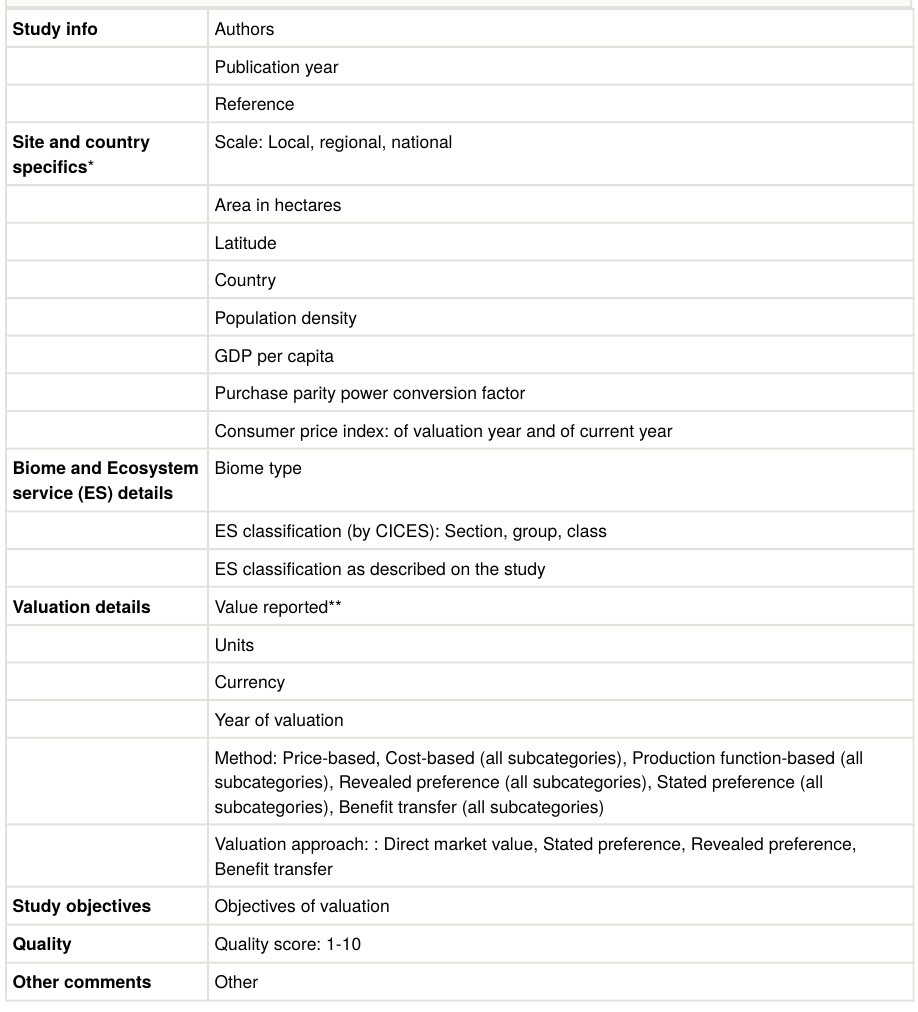
Data extraction template for ecosystem service